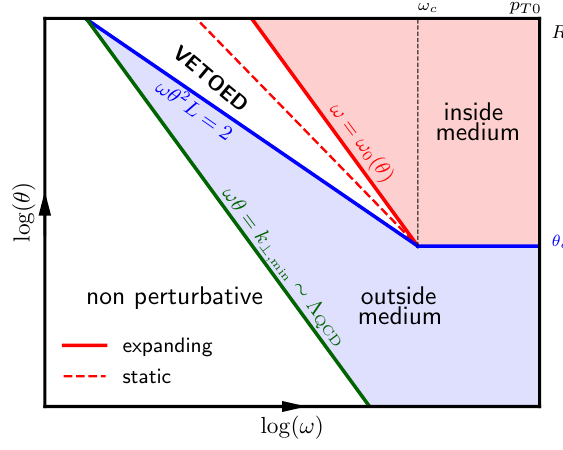
Figure 1. Double logarithmic phase space for VLEs in an expanding medium. The in-medium boundary (plain red line) is set by eq. (2.4) and is our reference choice for the Monte-Carlo imple- mentation. The (red) dashed line represents the boundary of the “equivalent” static medium (see the discussion in section